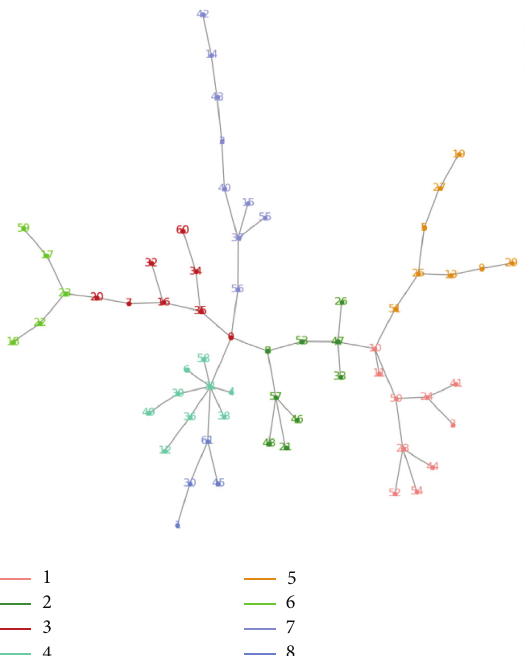
Figure 9: The community of energy stock price jump from October 2017 to April